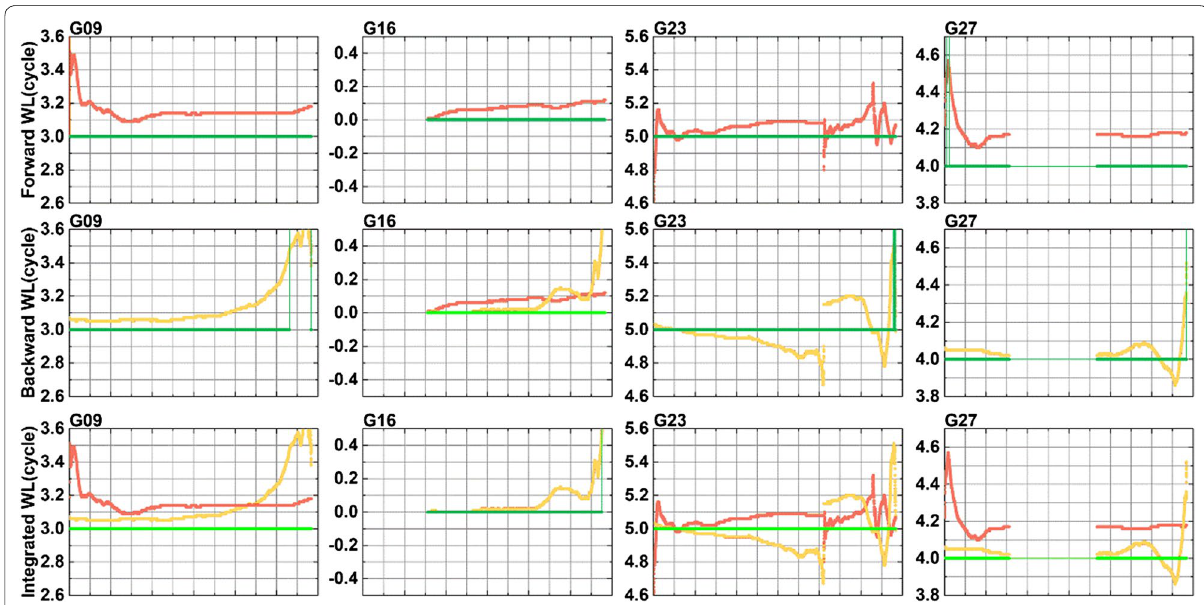
Fig. 4 WL resolution from the forward filter (top) and backward filter (middle) for G09, G16, G23 and G27. Red and yellow curve denote the ambiguity-float results in the forward filter and backward filter, respectively. The green curve is the respective ambiguity-fixed resolution. The bottom figures show the results of integration for G09, G16, G23, and G27. The light green curve denotes the integrated ambiguity. The range of x -axis is 3